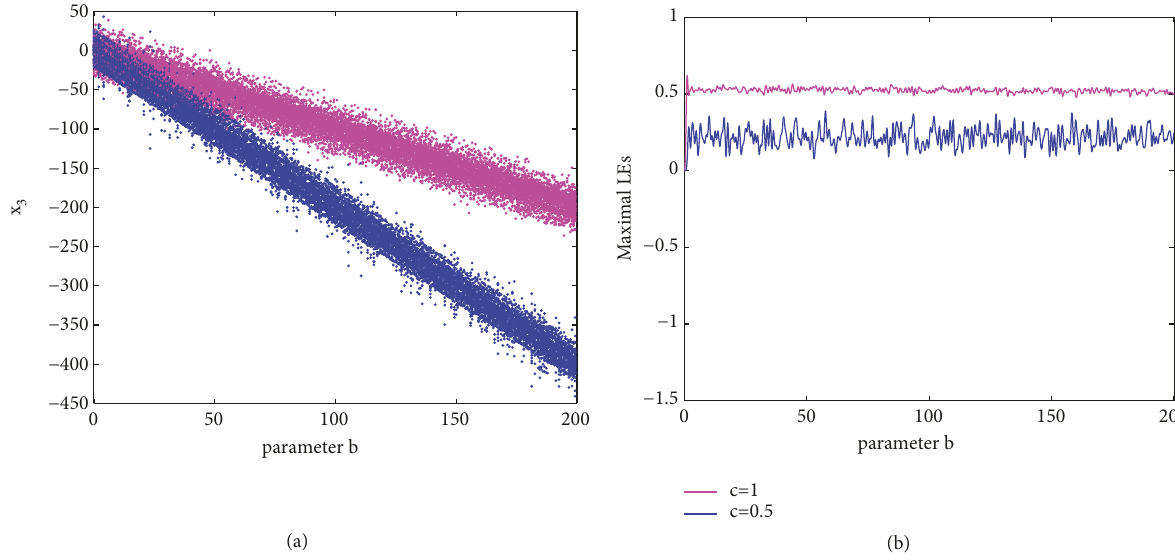
Figure 4: Influence of c on position modulation interpreted by (a) Bifurcation diagram and (b) Lyapunov exponent spectrum versus b with c =1 in magenta and c =0.5 in